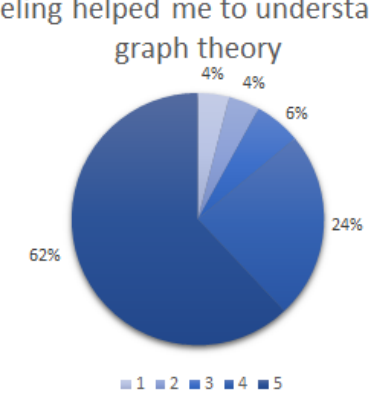
Figure 4. Students’ perceptions of assertion 1.